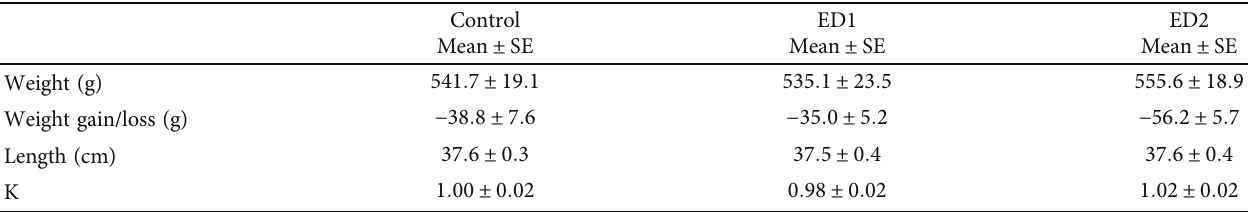
Table 7: Morphological parameters for Atlantic salmon that survived to the endpoint of the experiment (i.e., when 50% of each population ]); control ( n = 44 ), experimental diet # 1 (ED1; n = 46 ), and experimental diet # 2 (ED2; n reached their incremental thermal maximum [IT Max = 47